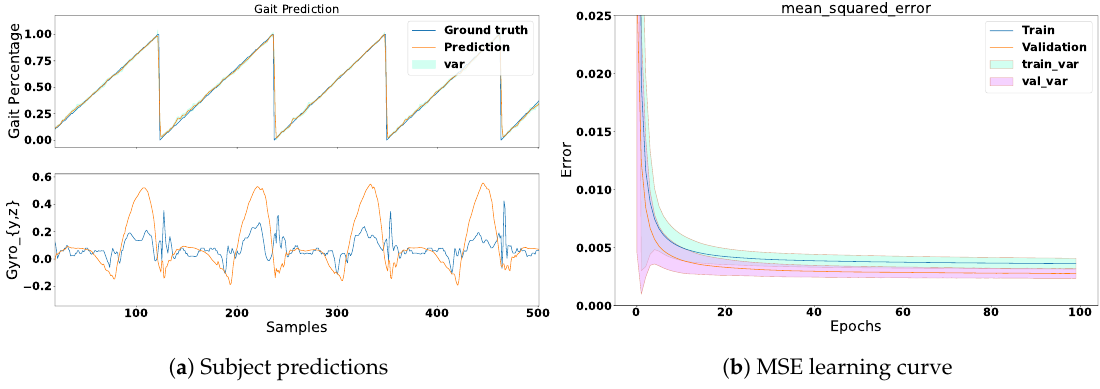
Figure 7. This figure shows the prediction and the results of the learning process for one subject. ( a ) The ground truth and mean prediction of the gait phase discretisation divided into 100 portions normalised between 0 and 1 (0 equals to 0 percent and 1 equals 100 percent of the gait cycle). The bottom figure shows the y and z signals of the gyroscope sensor; ( b ) The mean and variance of the mean square error (MSE) learning curve. The average of MSE reached a loss of 0.003 in the training set and 0.0662 in the validation set.